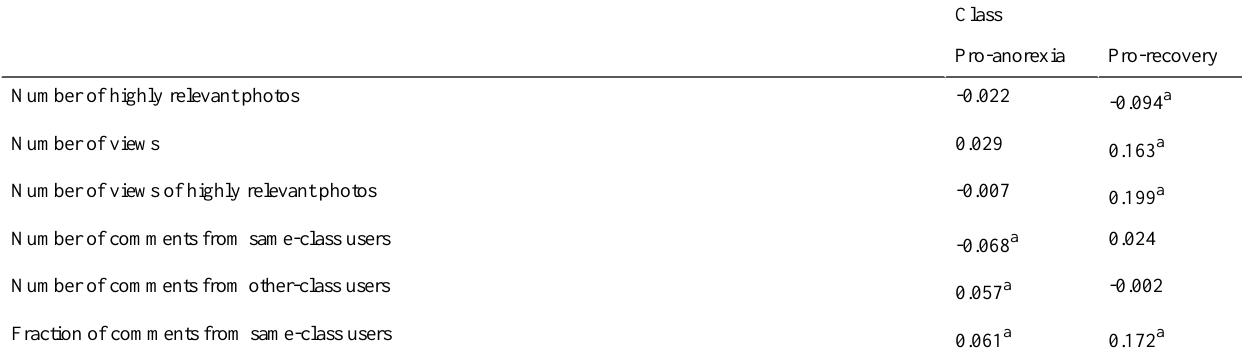
Table 3. Hazard model coefficients; recent features (calculated using data from the preceding 30